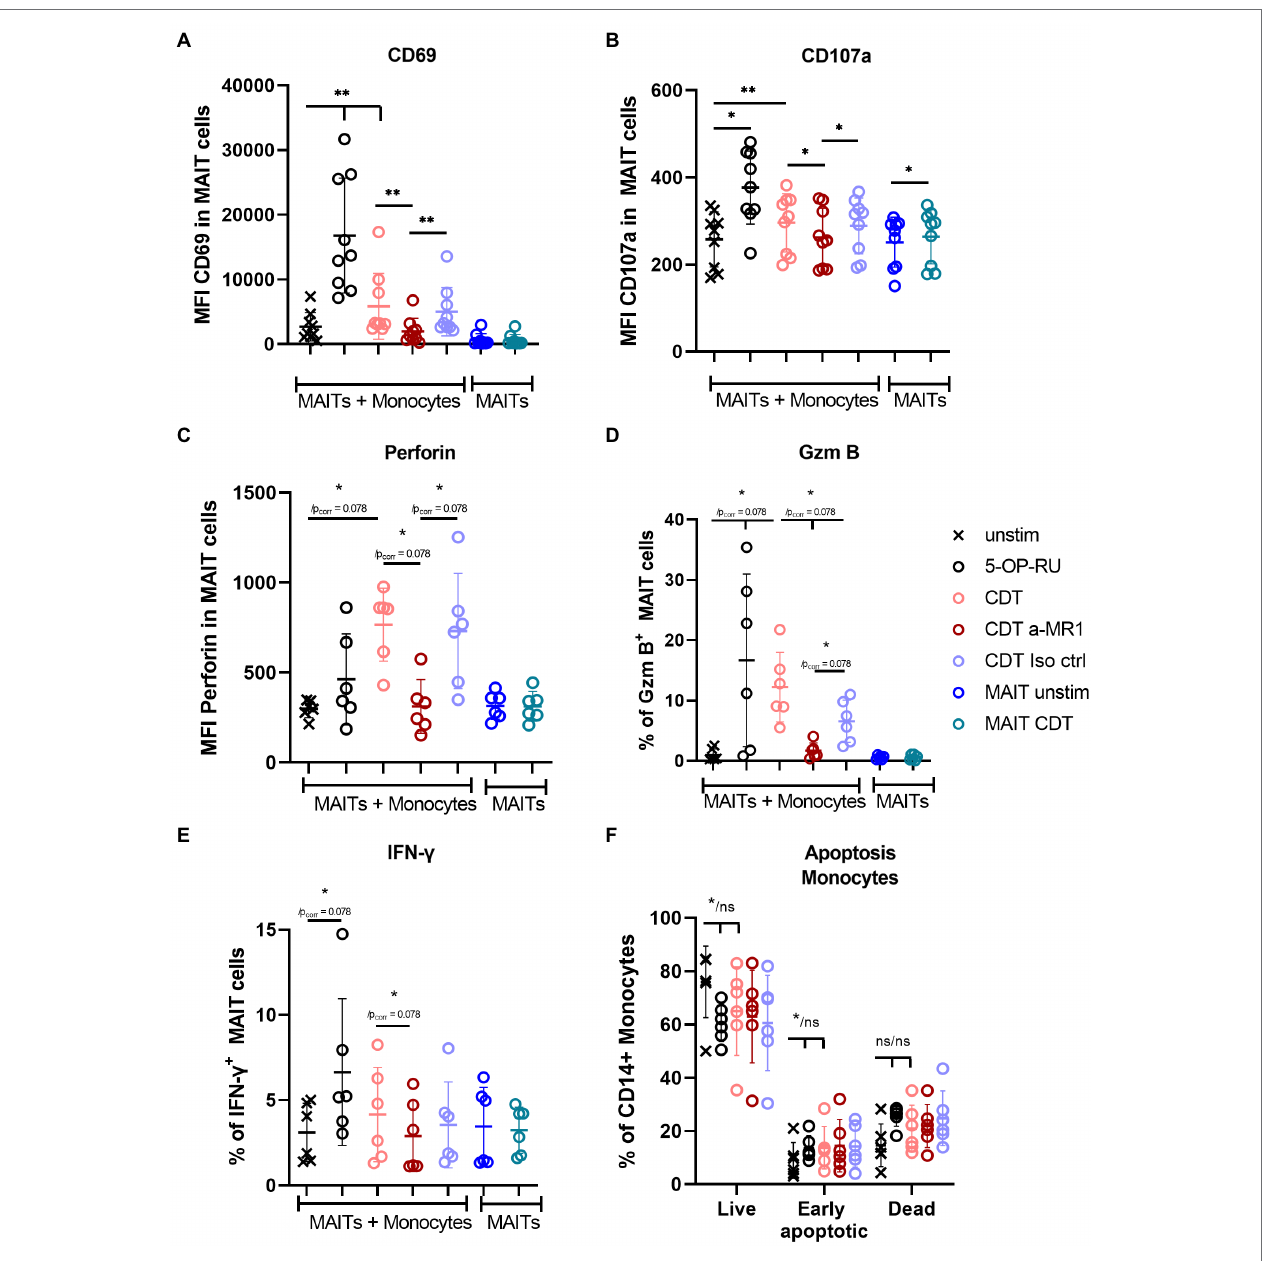
FIGURE 6 | Monocytes MR1-dependently activate MAIT cells in a bi-cellular model following CDT stimulation. C. difficile CDT (100 ng/ml) was directly applied to isolated CD161 ++ V α 7.2 + CD3 + MAIT cells and CD14 + monocytes (1:1 ratio) for 20 h. As indicated, in two conditions MAIT cells were stimulated without monocytes. MAIT cell activation was quantified by flow cytometric analysis determining CD69 (A) , CD107a (B) , intracellular perforin (C) , GzmB (D) and IFN γ (E) expression. Apoptosis of monocytes was determined by Annexin V Apoptosis Detection Kit with 7-AAD (F) . If indicated, cells were treated with anti-MR1 (a-MR1) or isotope control IgG1 (Iso ctrl) 1 h prior CDT stimulation. As positive control, cells were stimulated with 50 ng/ml 5-OP-RU for 20 h. Horizontal lines indicate mean ± SD. Asterisks indicate significant differences determined by Wilcoxon matched-pairs signed rank test with p values before and after Bonferroni Holm correction (*/p corr ); * p < 0.05; ** p < 0.01. If no corrected p value is given, asterisks indicate significances after the correction. For co-incubated MAIT cells and monocytes (MAITs + Monocytes) five tests were performed (A–E) : unstimulated (unstim) vs. (i) 5-OP-RU, (ii) CDT and CDT vs. (iii) a-MR1, (iv) Iso ctrl, and (v) a-MR1 vs. Iso ctrl. MAIT cells alone ± CDT were tested separately. In (F) three tests were performed between unstim and indicated conditions. Data of two to three independent experiments from six to nine donors are